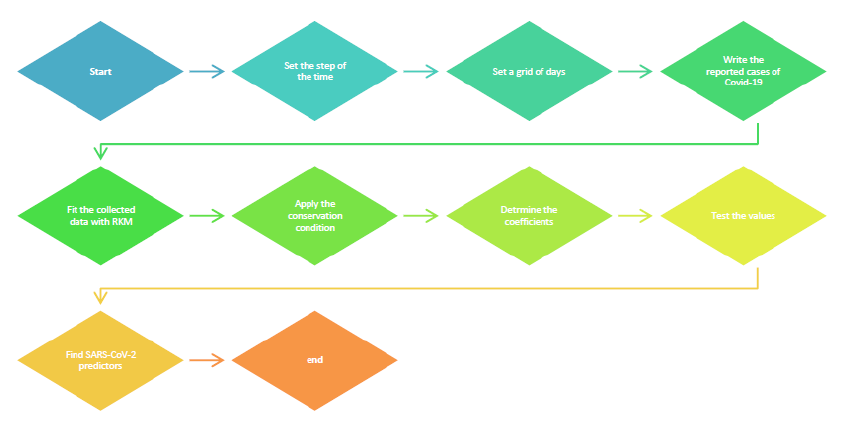
Figure 1. Schematic chart of the algorithm used in the